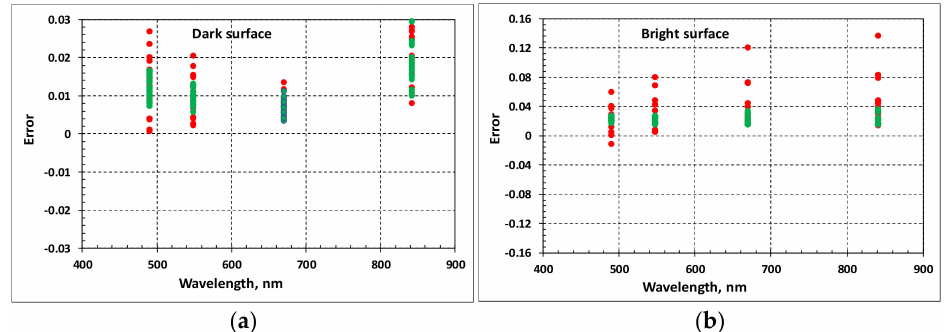
Figure 8. Errors in retrieving surface spectral reflectance in the MZ channels for dark surfaces ( a ) and bright surfaces ( b ) at Sun zenith angles 60 ◦ (red circles) and 20 ◦ (green triangles), an error of radiometric calibration in the MZ HR channels being 5%.